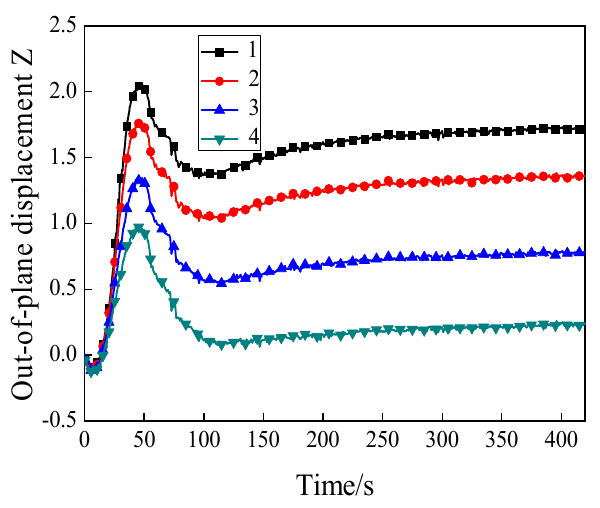
Figure 6. Dynamic out-of-plane deformation at key points in the thin bending plate. Because the welding position was on the convex surface, the compressive stress at the points during the welding process was along the tangential direction; thus, the thin bending plate rapidly became convex, which is related to the initial shape. The out-of-plane deformation evolution of the thin bending plate from dish to saddle was completed during the welding cooling process (100 s).